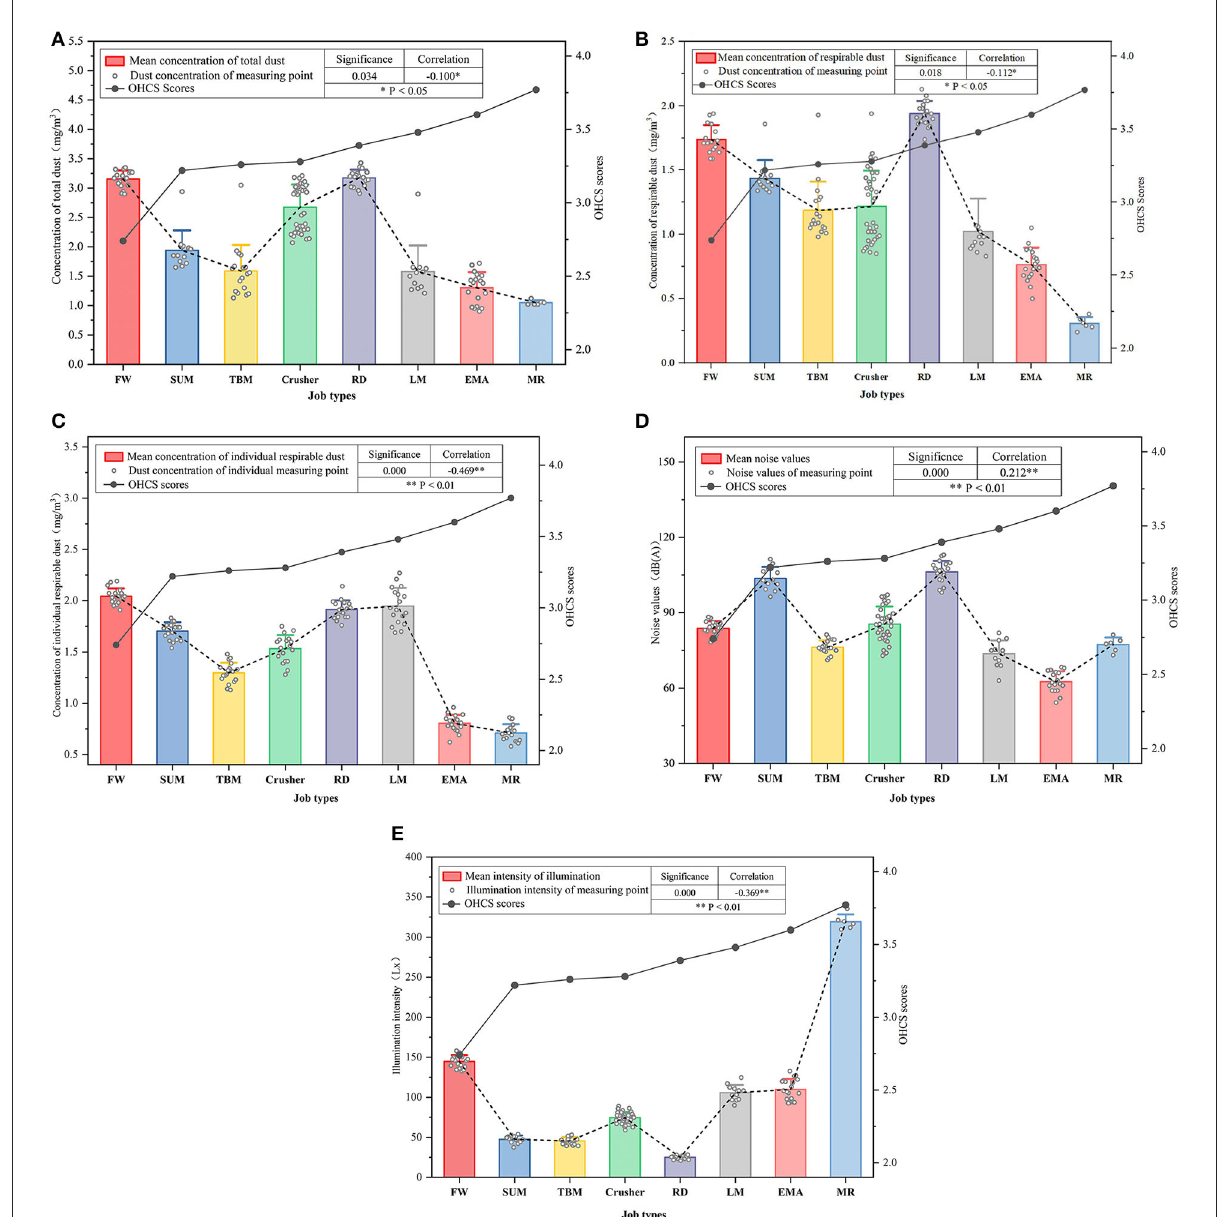
FIGURE6 (A) Workplace total dust concentration and miners’ OHCS score distribution. (B) Workplace respirable dust concentration and miners’ OHCS score distribution. (C) Workplace individual respirable dust concentration and miners’ OHCS score. (D) Workplace noise values and miners’ OHCS score distribution. (E) Workplace illumination and miners’ OHCS score